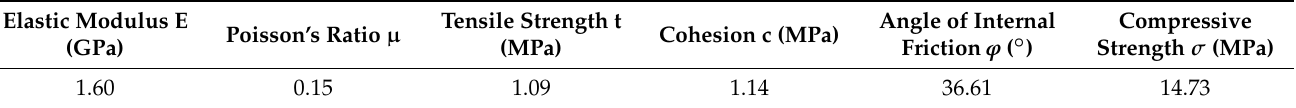
Table 1. Table of physical and mechanical parameters of test coal samples.